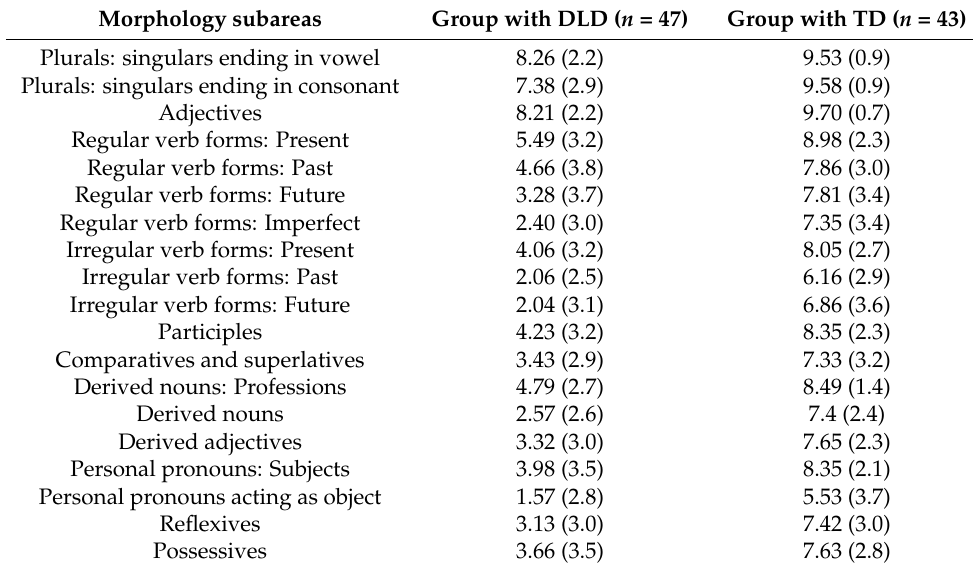
Table 2. Score averages in the morphology subareas.